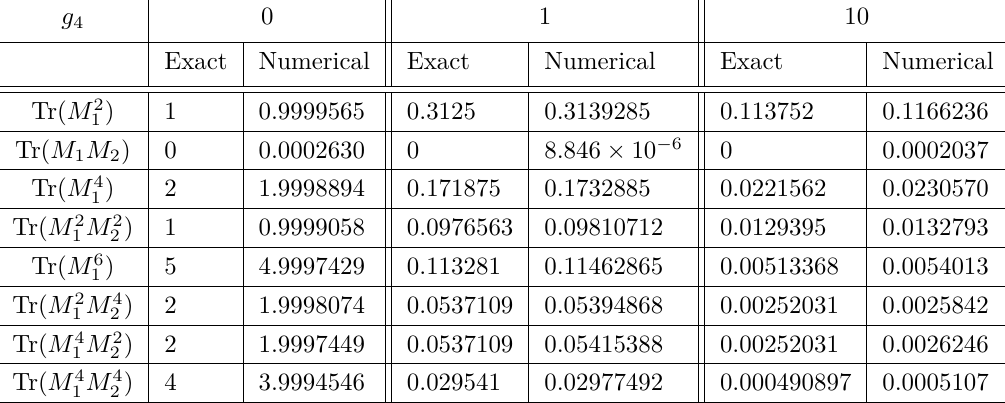
Table 2. Results for the g 3 = k = 0 as g 4 is varied. The table shows loops with lengths ≤ 8 .